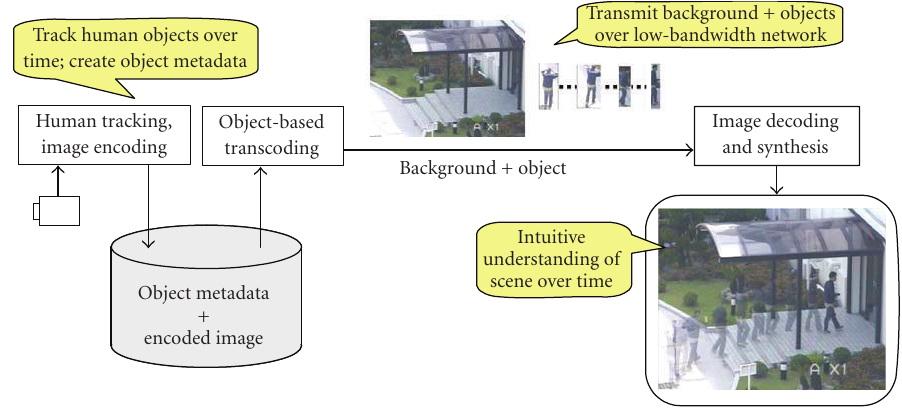
Figure 1: Object-aware streaming system for